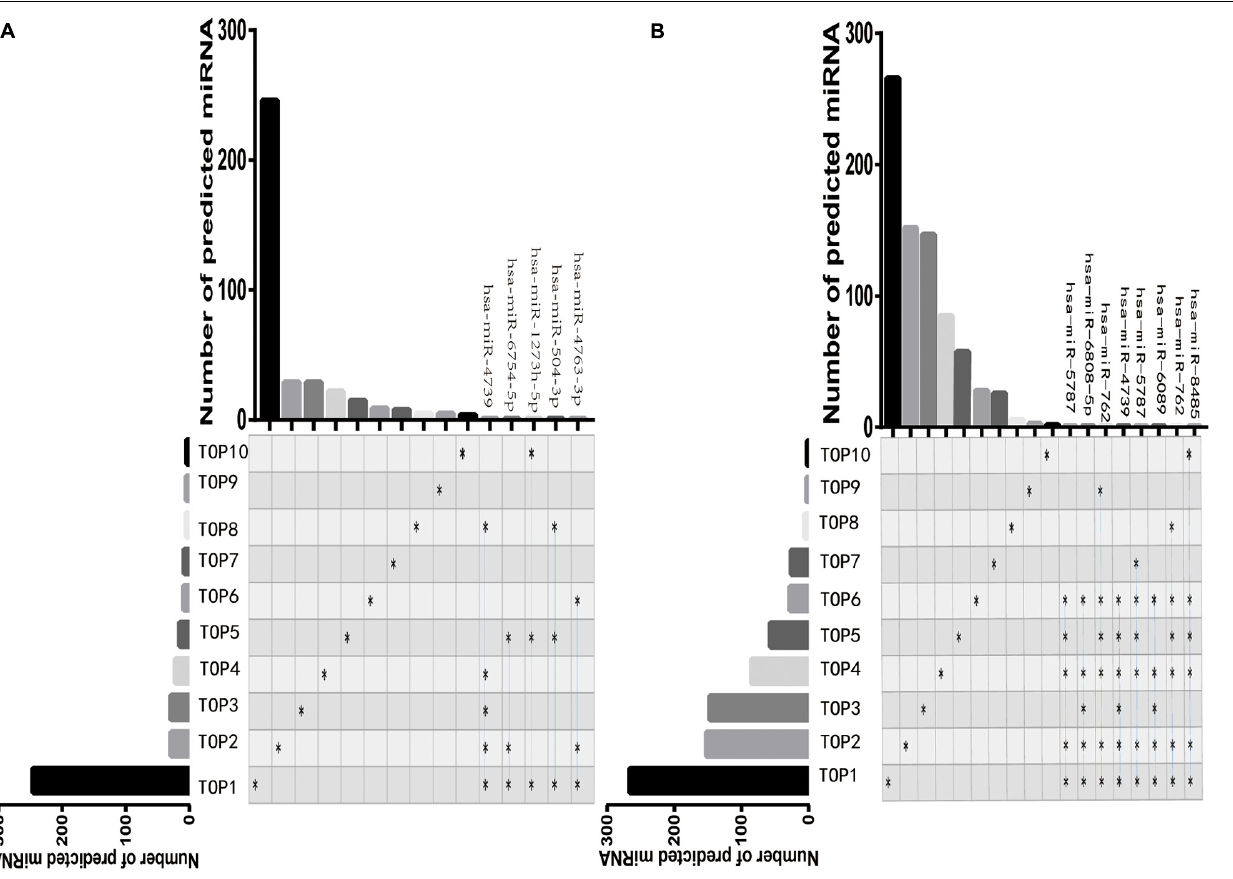
FIGURE 4 | The visualization map of DE-circRNAs target miRNAs. The composite matrix graph shown visualize set overlap. The vertical axis presents the number of target miRNAs of each DE-circRNA. The black star on the left side of the matrix and the corresponding column above represent the number of miRNAs predicted by the differentially top10 expressed circRNA. The blue line and the stars on the right represent that the target miRNA predicted by the top10 DE-circRNA overlapped at least three times among different groups. Top1-top10 represent the top ten DE-circRNAs. A, The visualization map of the top 10 upregulated DE-circRNAs. B, The visualization map of the top 10 downregulated